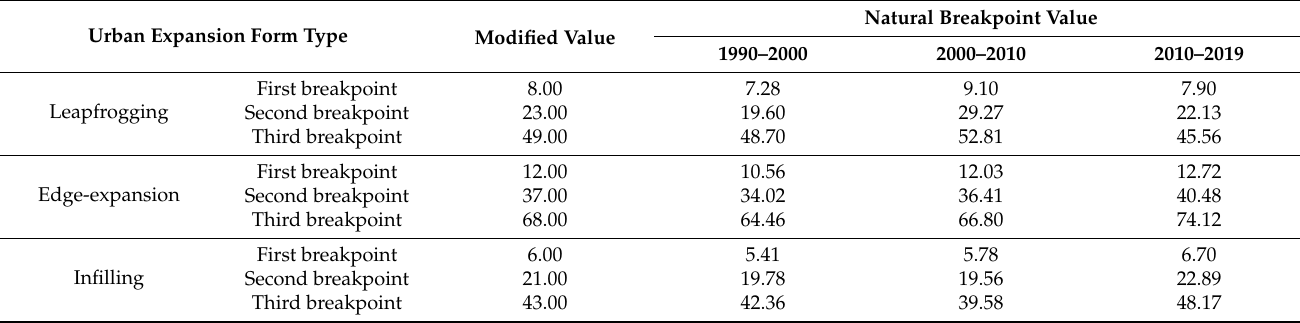
Table 2. The modified breakpoint values and natural breakpoint values for classifying the levels of urban expansion intensity. Urban Expansion Form